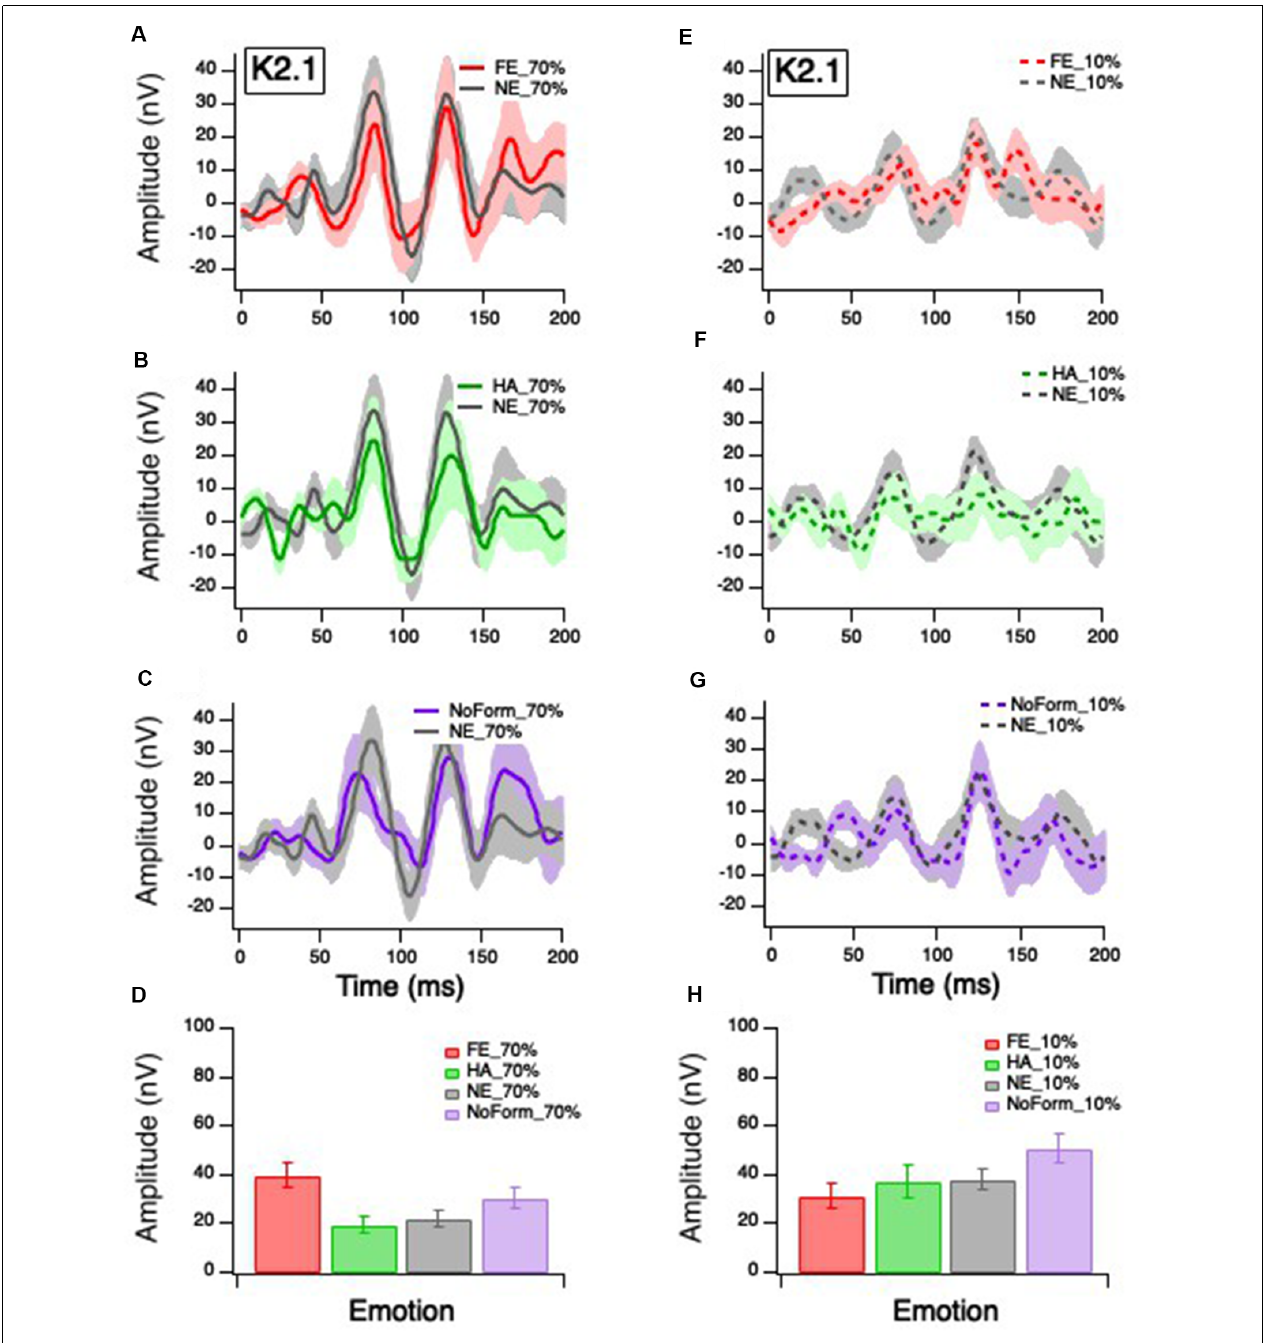
FIGURE 3 | Grand mean average K2.1 responses. Solid red, green and purple lines correspond to the averaged waveforms for the 70% temporal contrast conditions with (A) fearful, (B) happy, and (C) no form stimuli superimposed in the central stimuli, respectively, all plotted against (gray). Dashed red, green and purple lines correspond to the averaged waveforms for the 10% temporal contrast conditions with (D) fearful, (E) happy, and (F) no form superimposed in the central patch, respectively, all plotted against (gray). Mean peak amplitude values of K2.1N60-P90 for 70% and 10% temporal contrast conditions across all emotions are shown in (G,H) , respectively, to illustrate the significant emotion by contrast interaction.